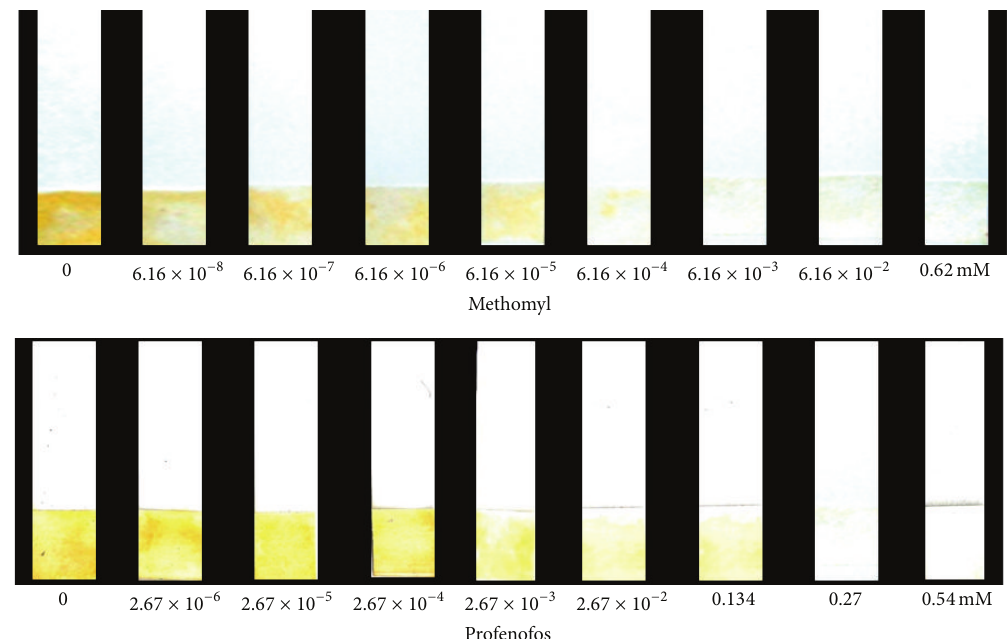
Figure 5: Relationship between inhibition of AChE activity and different concentrations of methomyl and profenofos using paper-based biosensor